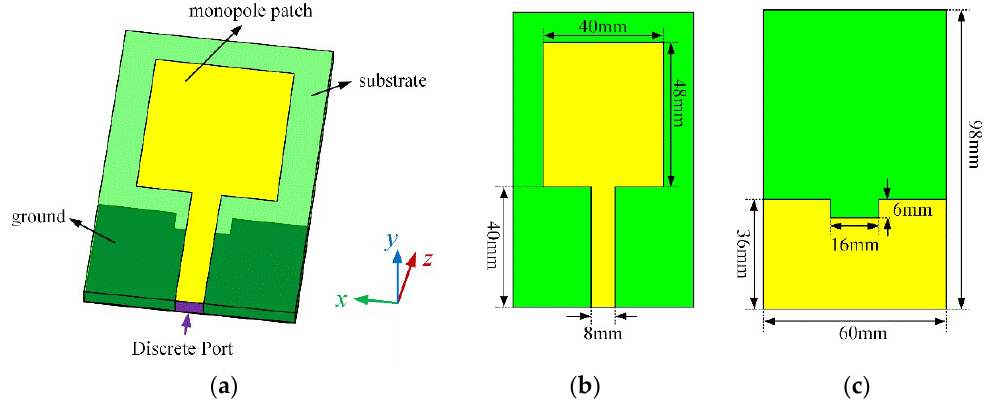
Figure 3. Structure and dimensions of the planar monopole antenna: ( a ) side view; ( b ) top view; ( c ) bottom view.